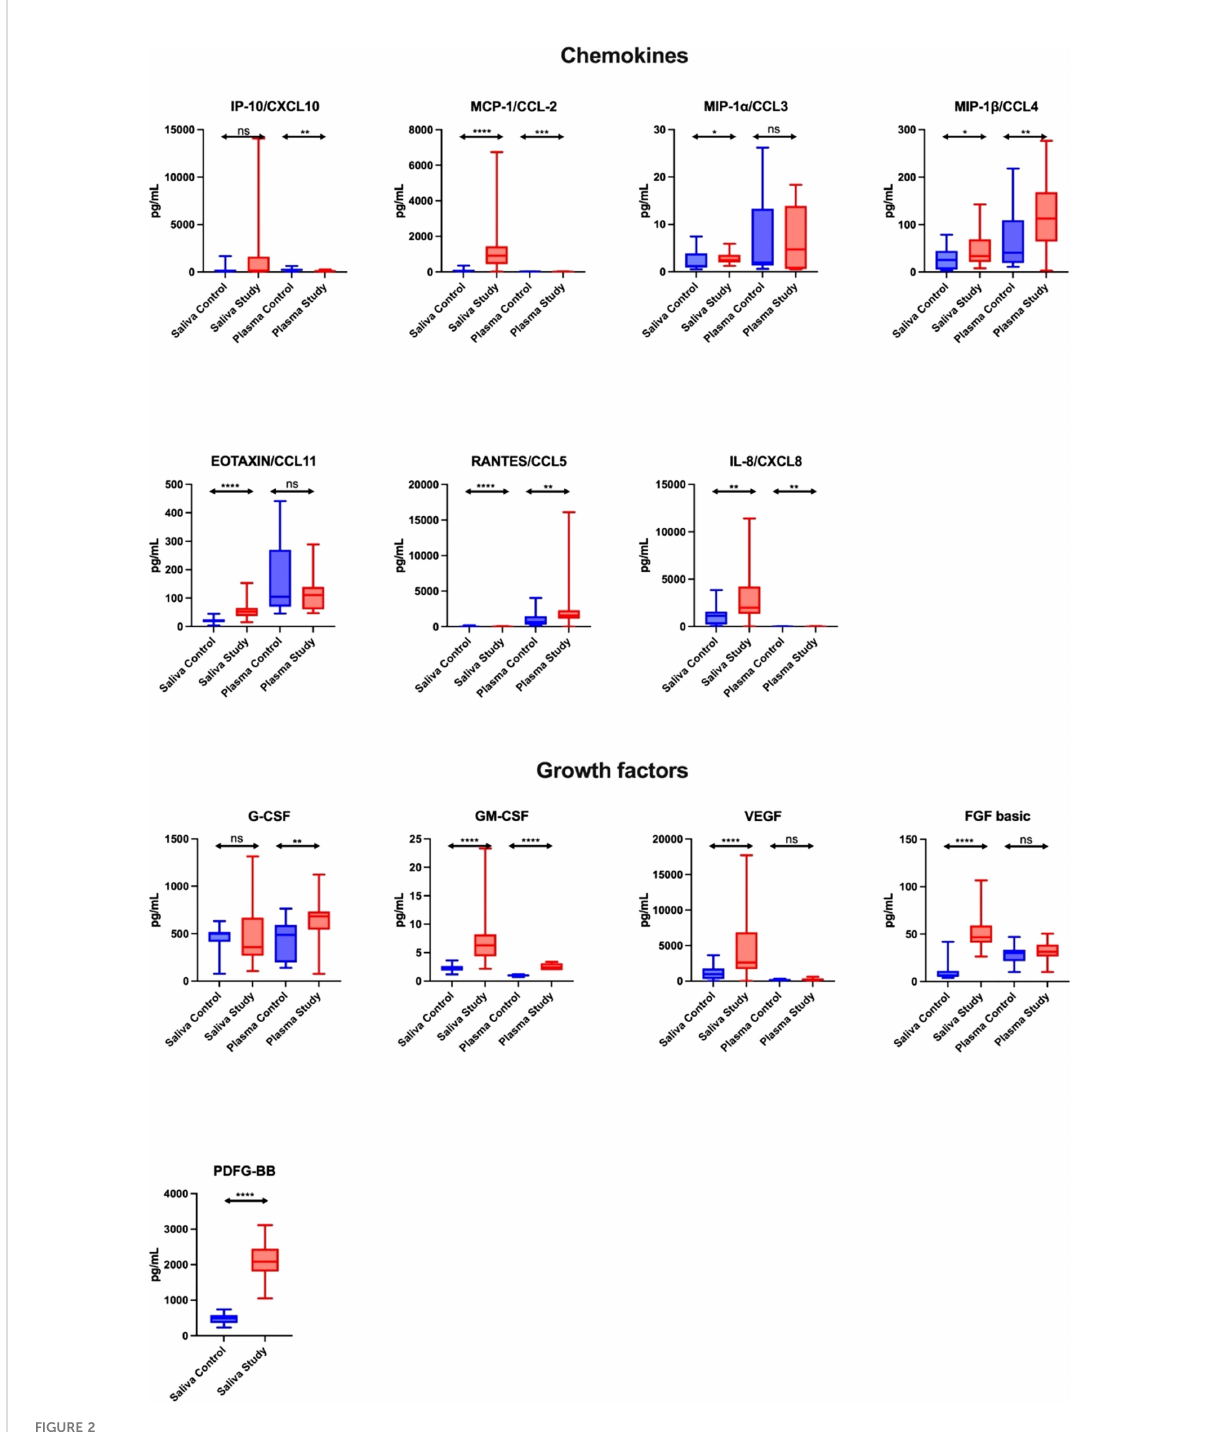
FIGURE 2 Salivary chemokines and growth factors in patients with heart failure (n = 30) compared to the control (n = 30). The results are presented in box-and-whisker plots as median (minimum-maximum). For comparisons between the two groups, the Whitney U-Mann test was used. *p< 0.05, **p< 0.01, ***p< 0.001, and ****p< 0.0001. NS, non signi fi